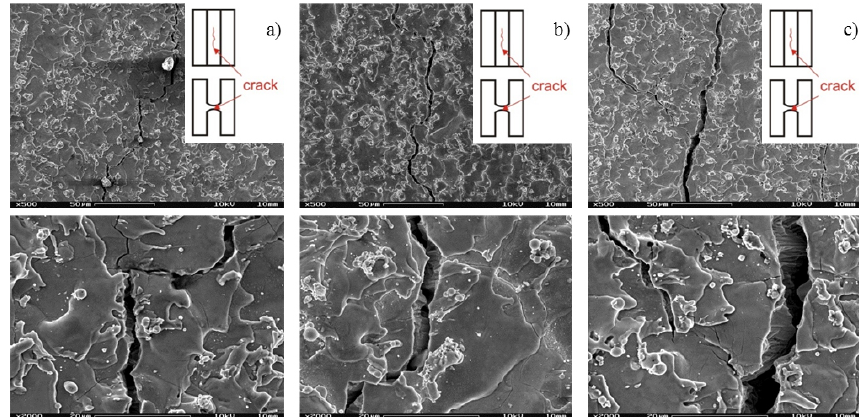
Figure 12. SE images of cracks on the notch surfaces of three specimens: (a) a decline of 25 + 25%, (b) a decline of 25 + 50% and (c) a decline of 25 +